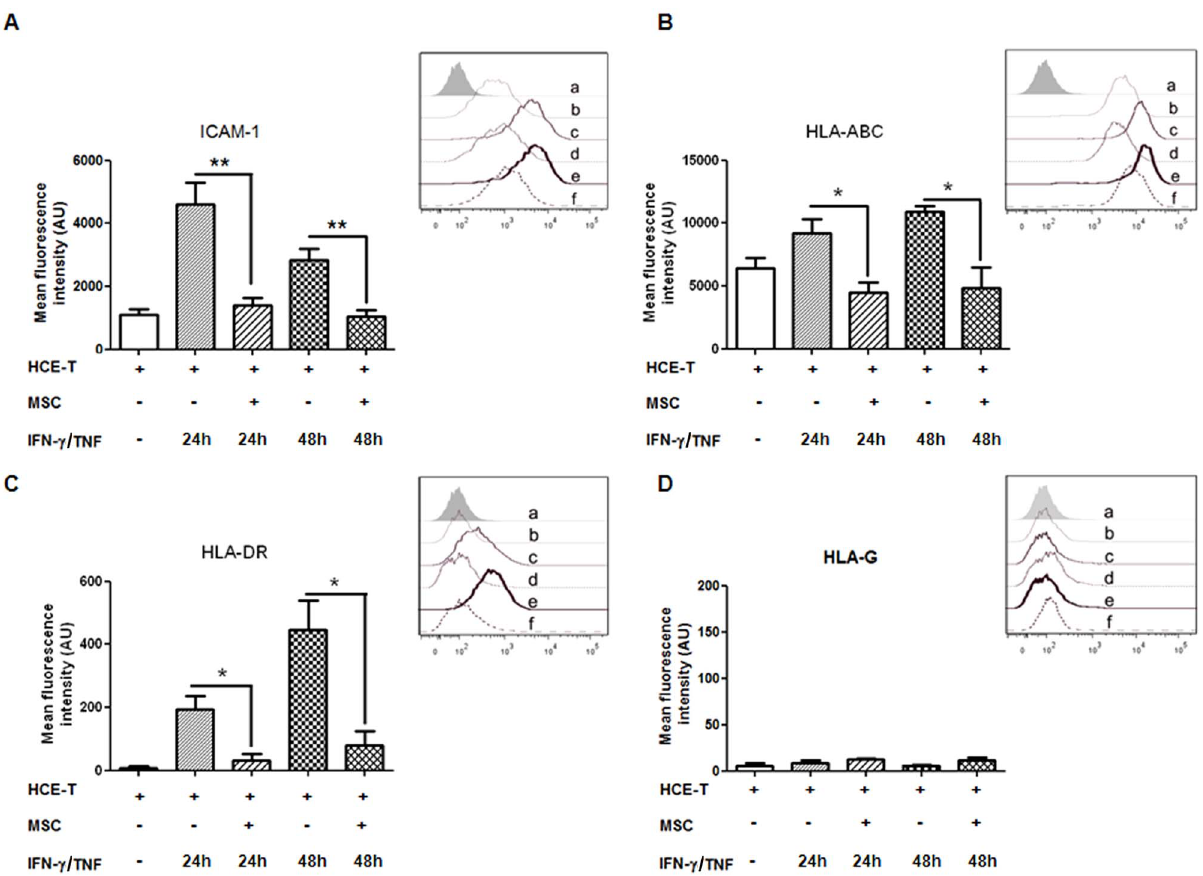
Figure 2. Modulatory effects of MSC on IgSF molecule expression. Bar graphs showing the relative expressions of ICAM-1 ( A ), HLA-ABC ( B ), HLA-DR ( C ) and HLA-G ( D ) on HCE-T cells, as determined by FCM. HCE-Ts were either untreated or treated for 24 h and 48 h with IFN- c (100 U/ml) and TNF (100 U/ml) on monocultures and HCE-T/MSC co-cultures. The inserts are representative FCM histograms, and the abscissa represents log10 fluorescent intensity in arbitrary units (AU) [a. isotype control Alexa 488 conjugated mouse IgG; b. untreated HCE-T; c. 24 h IFN- c /TNF treatment on HCE-T monoculture; d. 24 h IFN- c /TNF treatment on HCE-T/MSC co-culture; e. 48 h combination cytokines stimulation on HCE-T monoculture; f. 48 h combination cytokine stimulation on HCE-T/MSC co-culture]. Data represents mean 6 SEM of four separate experiments (n=4). *: p , 0.05, **: p , 0.01. The ‘‘ + ’’ or ‘‘-‘‘ symbol denotes the presence or absence of the denoted treatment or cell type at the left.